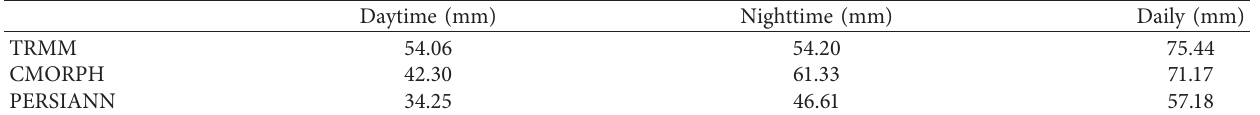
Table 5: Maximum precipitation during the daytime, nighttime, and the whole